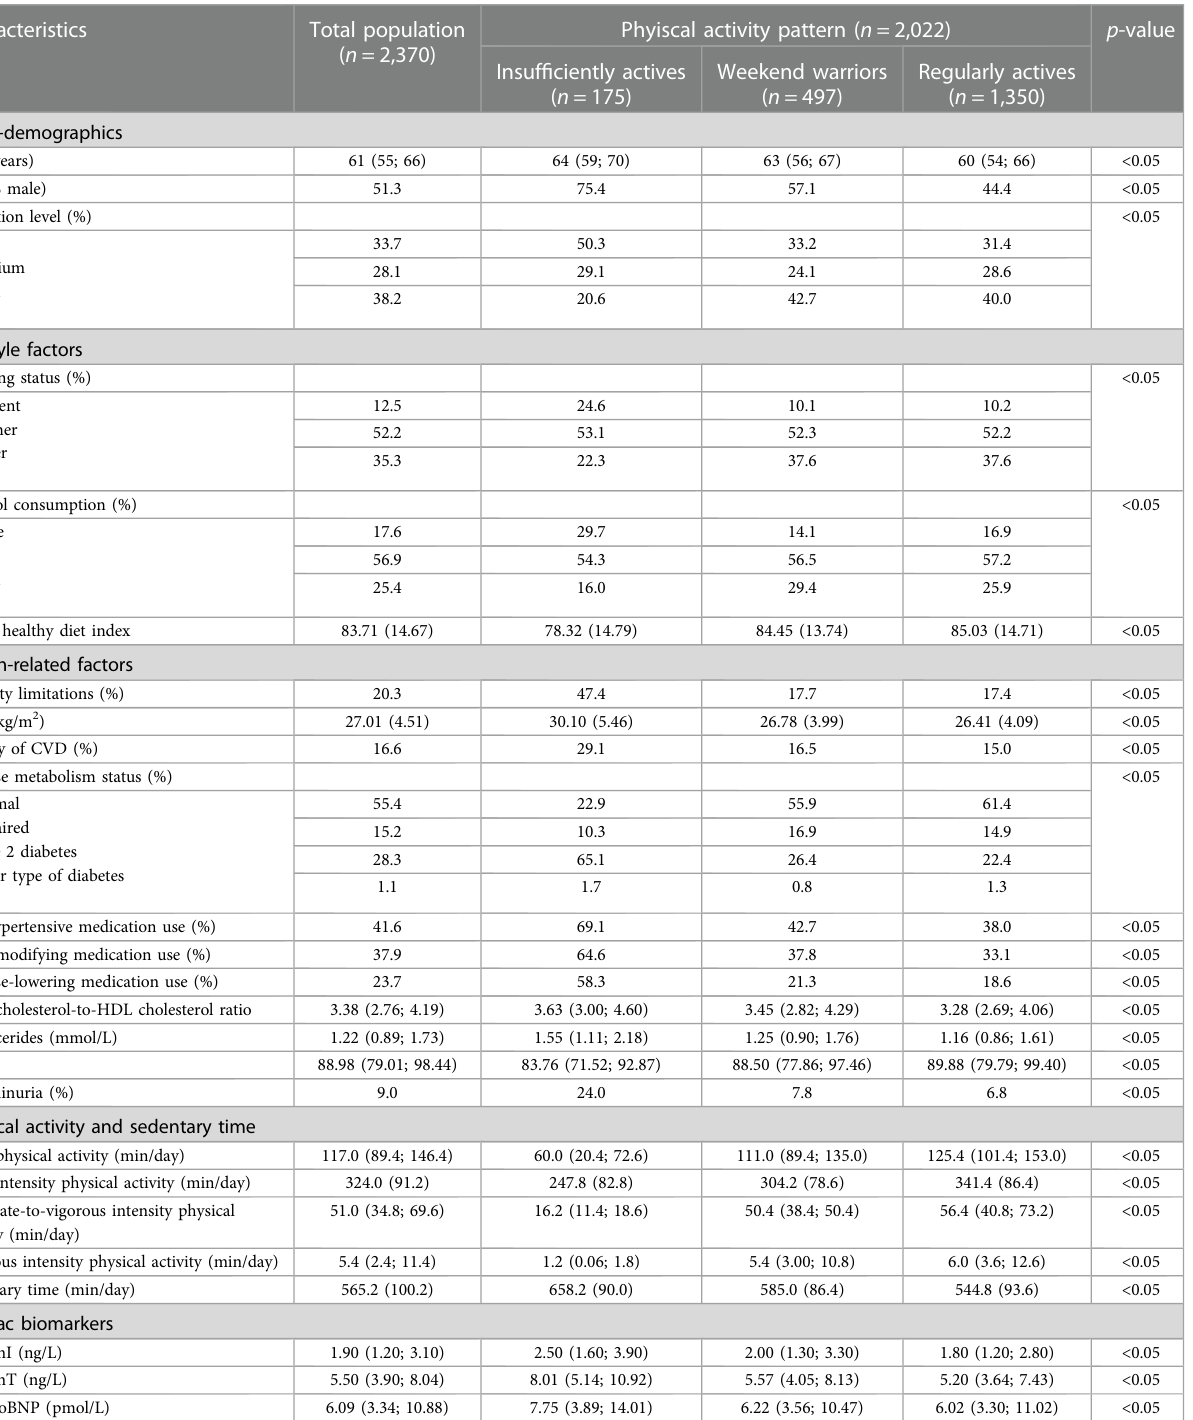
TABLE 1 Descriptive characteristics of the study population.